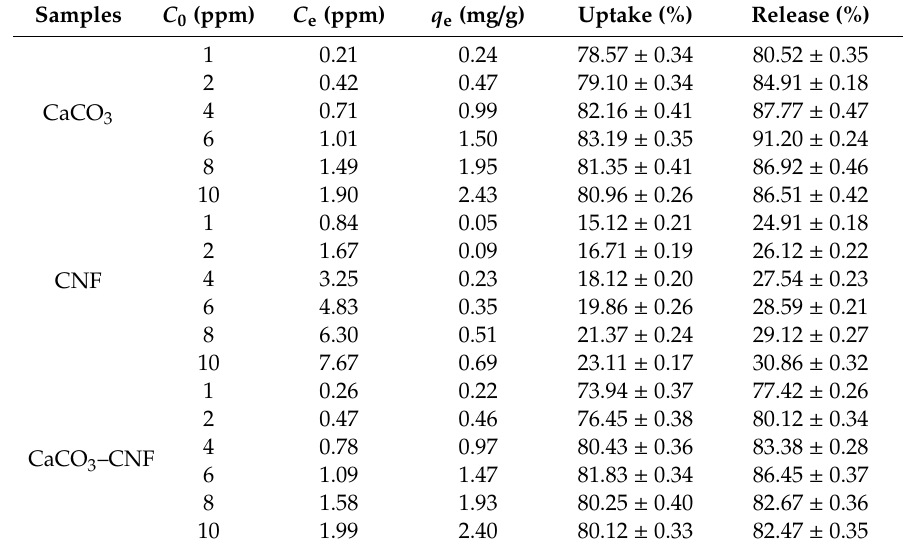
Table 1. Kinetics data of the total uptake and the release at di ff erent initial concentrations of 5-FU on the casted films of CNF, CaCO 3 and CaCO 3 –CNF. The data are presented as mean ± standard deviation ( n =